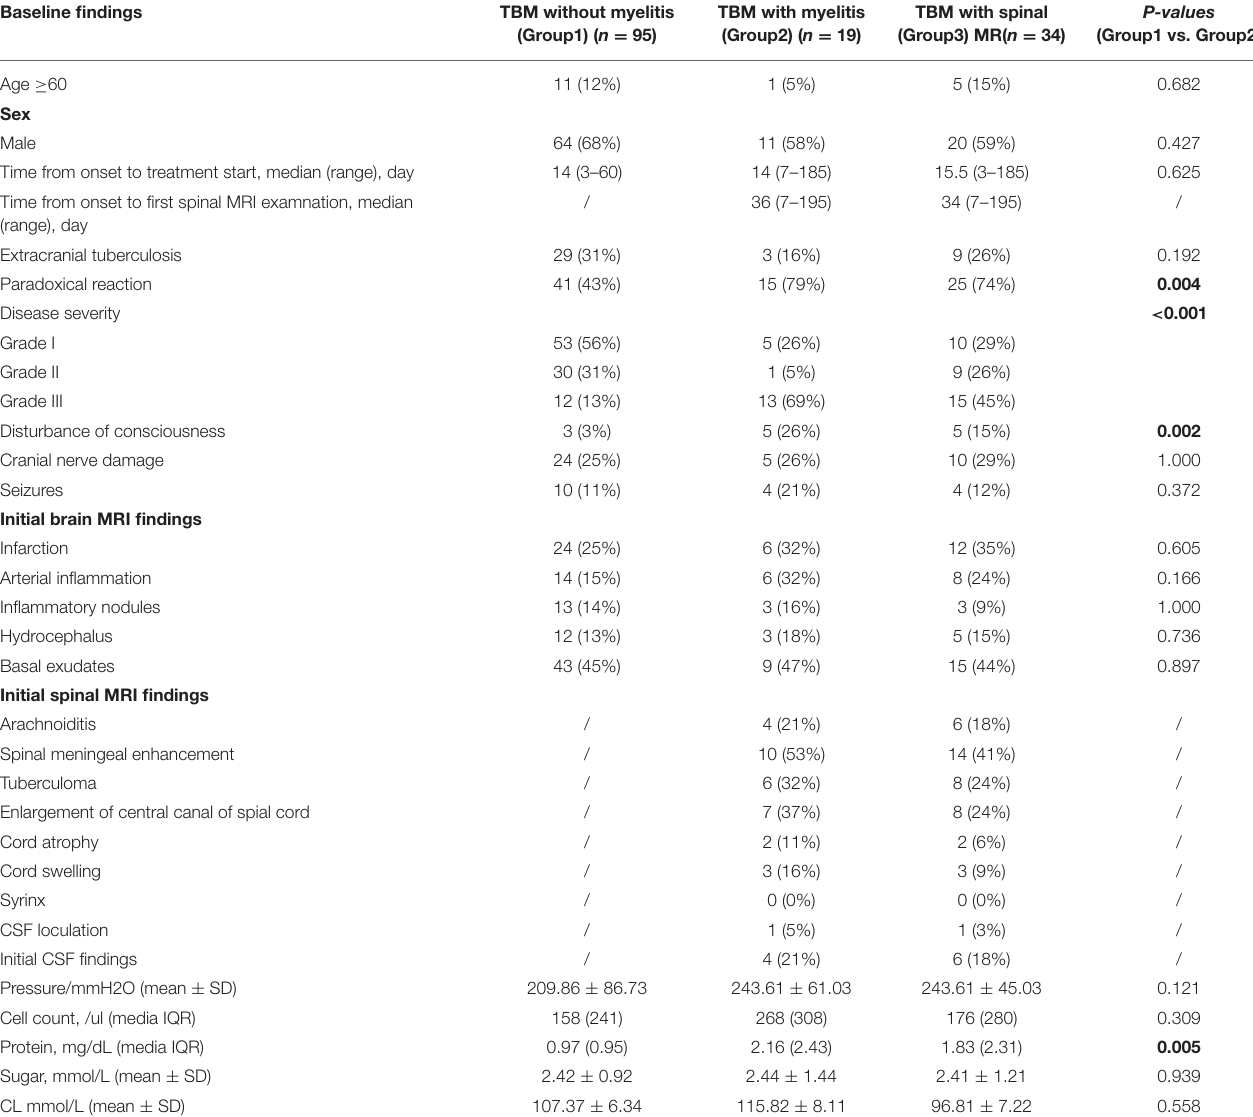
TABLE 1 | Baseline epidemiological, clinical, and neuroimaging characteristics of patients with tuberculous meningitis (TBM) ( n = 114). Baseline findings TBM without myelitis